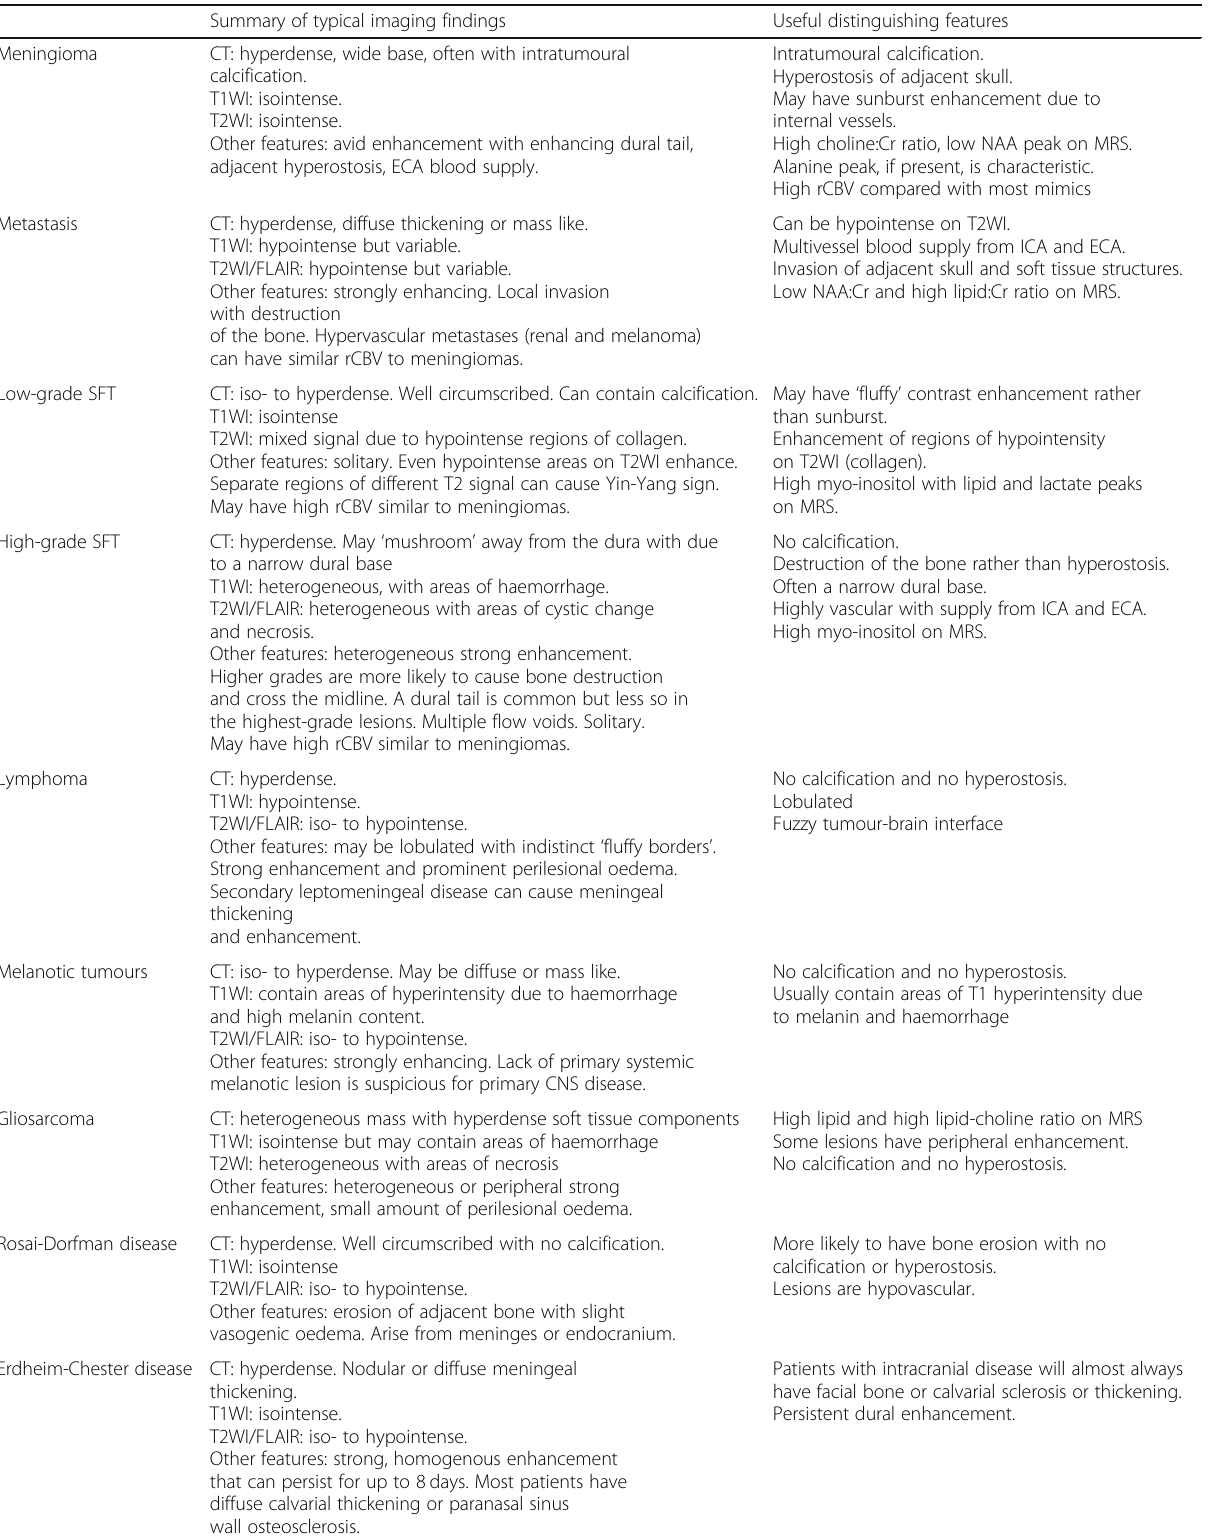
Table 2 Summary of the imaging findings in meningiomas and their mimics Summary of typical imaging findings Useful distinguishing